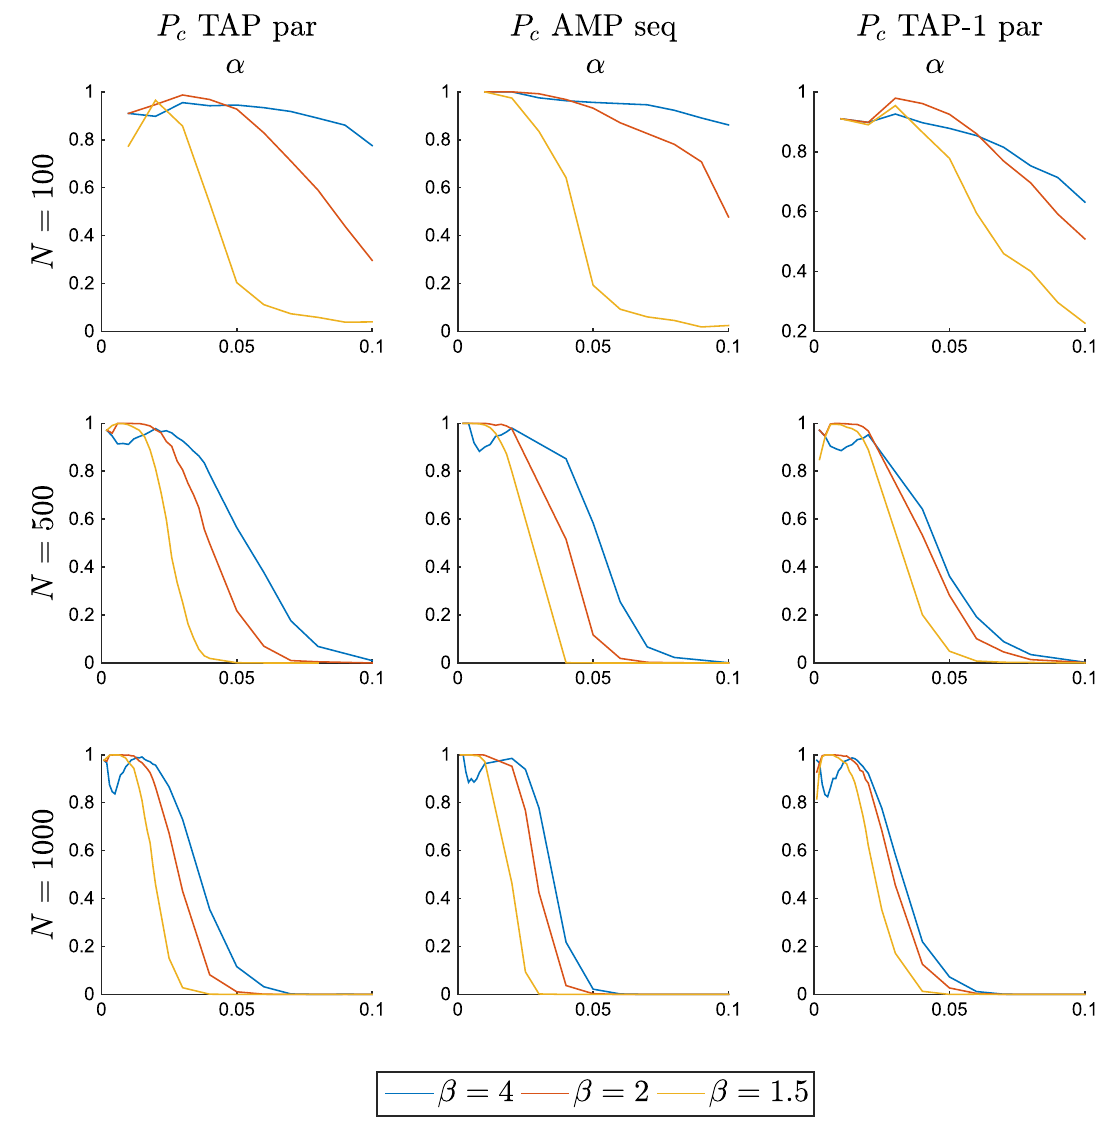
Figure 7. Probability of converging to a pattern when iterating Eq. (7) (left), Eq. (8) (center), Eq. (13) (right), starting from a random initial condition in the direct problem. This probability is estimated running 1000 independent experiments from different realizations of the patterns and different initial conditions and counting the number of times that the equations converged to one of the patterns of the system with overlap greater than 0.7, in order to exclude mixture states. The sequential updating of the AMP equations is done with a dumping term equal to 0.95. The performance of all these algorithms is similar, with the second one being much slower. The initial absolute value of the local magnetizations are mostly irrelevant in the first two cases (and it is chosen to be 1), but needs to be chosen small at low temperatures in the third case (and it is chosen to be